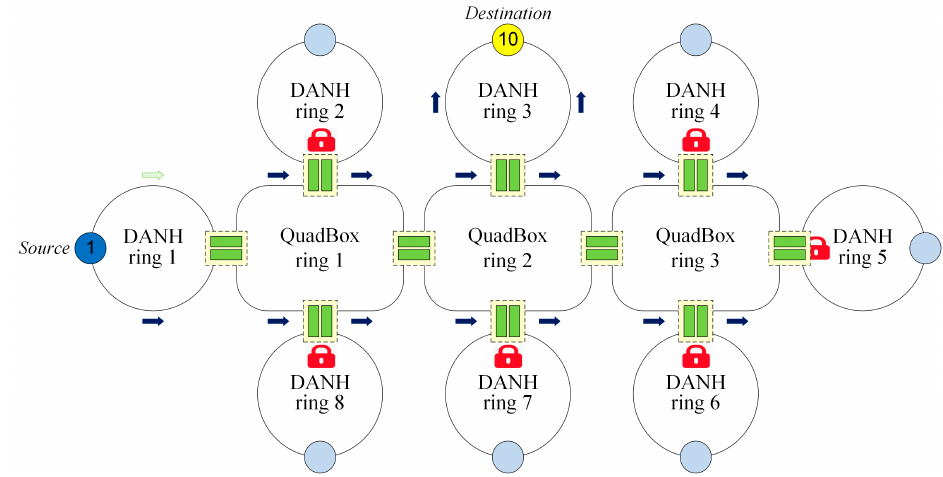
Figure 5. Forwarding a unicast frame using the hybrid QR and PL (QRPL) approach.